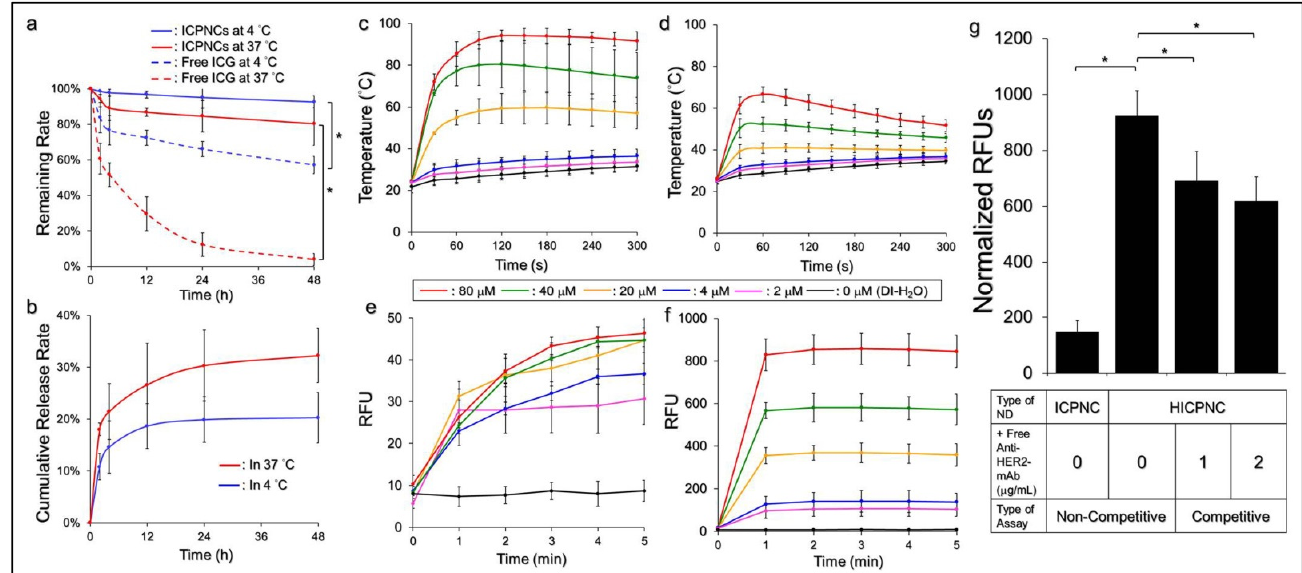
Figure 2. Assessment of stability and functionality of the ICPNCs in vitro. ( a ) Quantitative analysis of ICG remaining in the ICPNCs or PBS under incubation at 4 or 37 °C for 48 h. ( b ) Cumulative release profiles of the ICPNC-encapsulated CPT under incubation at 4 or 37 °C in PBS for 48 h. ( c , d ) Temperature elevation profiles of freely dissolved ICG ( c ) and the ICPNCs ( d ) under NIR irradiation for 5 min. ( e , f ) Singlet oxygen productions of freely dissolved ICG ( e ) and the ICPNCs ( f ) under NIR irradiation for 5 min. The yield of singlet oxygen was assessed based on the intensity of the SOSG-induced fluorescence measured by spectrofluorometry performed with 488/525 nm of excitation/emission wavelength and quantitatively represented by RFUs. In ( c – f ), groups with different ICG concentrations are denoted by different line colors as indicated in the figure. NIR irradiation was performed using an 808-nm laser with an output intensity of 6 W/cm 2 for 5 min. ( g ) Verification of HER2-binding specificity of the HICPNCs. The histogram shows the fluorescence levels of the BT-474 cells after treatment with ICPNCs or HICPNCs in the presence (competitive; 1 or 2 μ g/mL) and absence (non-competitive) of free anti-HER2-mAb for 4 h. The ICPNCs and HICPNCs containing 40 μ M ICG and 7.5 μ M CPT were employed for the experiment. The intensities of ICG-derived fluorescence were measured by spectrofluorometry performed with 750/838 nm of excitation/emission wavelength and were quantitatively represented by RFUs. Values in ( a – g ) are mean ± s.d. ( n = 3). * p < 0.05.